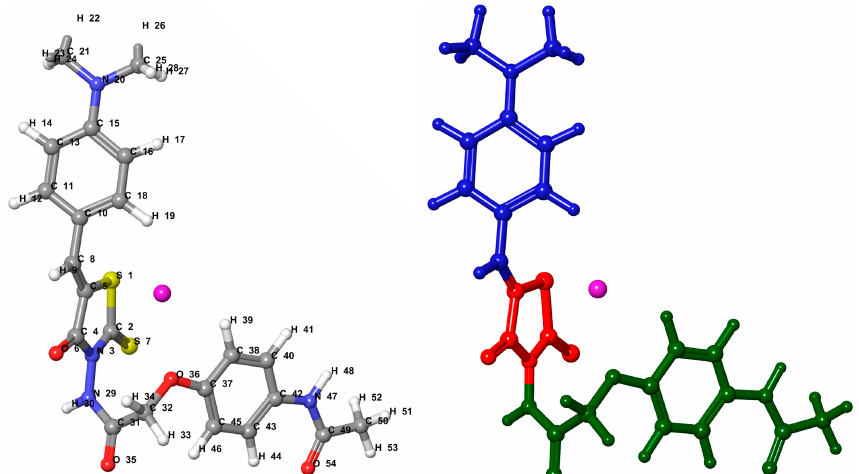
Figure 13. Les5 (Les-3834)—the numbering of atoms (left) and the split into fragments (common core Φ —red; R2—green; R4—blue). The geometric center of the molecule is marked pink.